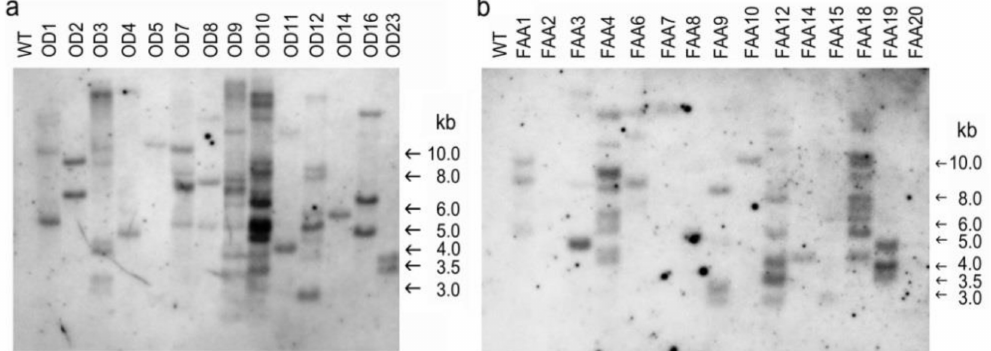
Figure 5. Southern blot analysis. ( a ) Southern blot analysis of transgenic OD plants. ( b ) Southern blot analysis of transgenic FAA plants. Twenty micrograms of DNA was digested with Eco RI and probed with the Digoxigenin (DIG)-labeled PCR product of nptII (795